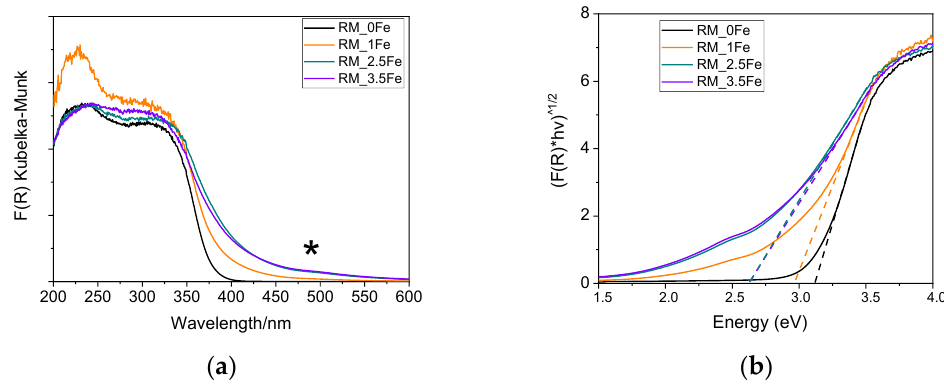
Figure 6. ( a ) DR UV-Vis spectra of the following powder samples at room temperature: RM_0Fe (black curve), RM_1Fe (orange curve), RM_2.5Fe (green curve) and RM_3.5Fe (violet curve). The asterisk at ca 490 nm indicates the possible d-d transitions of Fe3+ ions. ( b ) corresponding Tauc’s plots, as obtained by assuming indirect semi-conductor behavior.